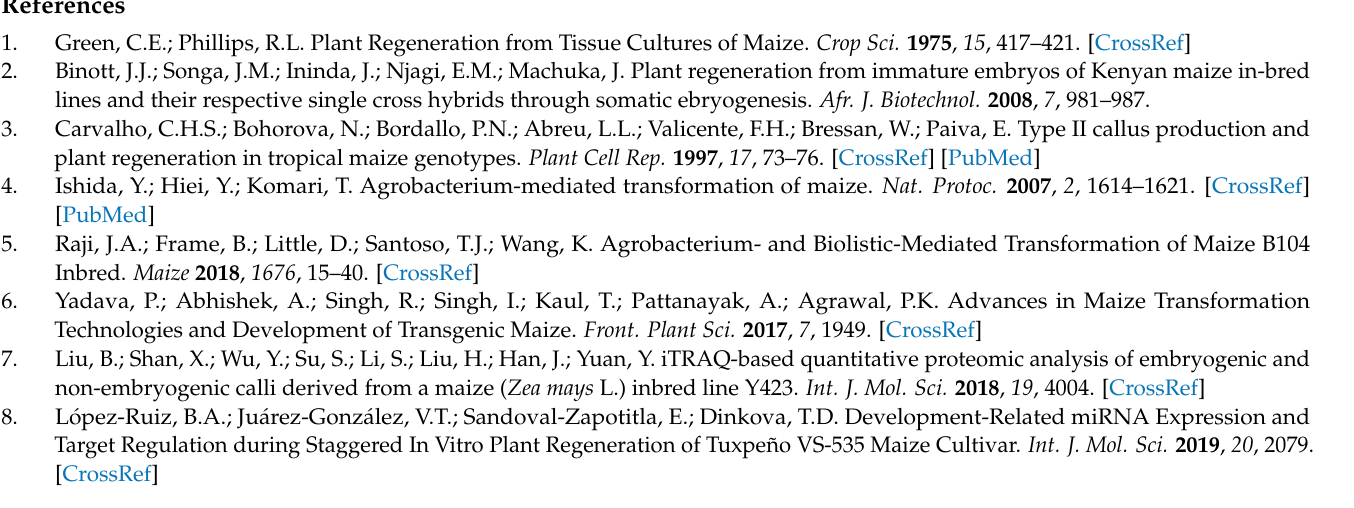
primers of the candidate genes, Table S4: Phenotypic data for the segregating populations in 2020 and 2021, Table S5: Summary of the genetic linkage maps for the F 2